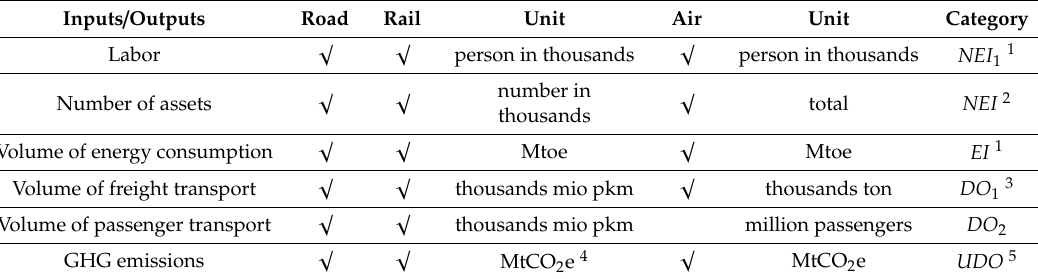
Table 3. Variables for road, rail and air transport